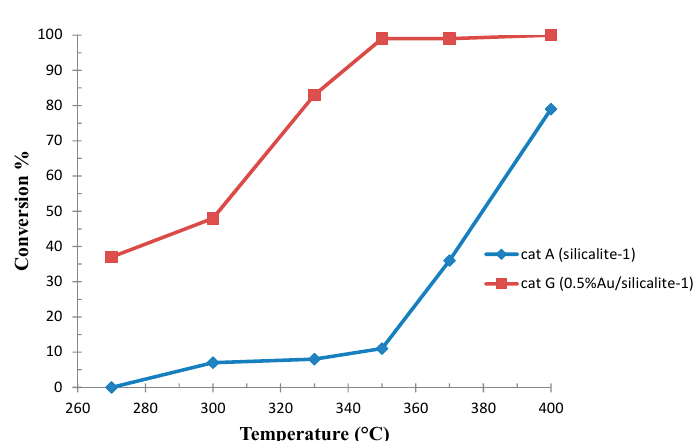
Figure 3. Comparison between unloaded silicalite-1 (cat A) and 0.5% Au/silicalite-1 (cat G) in ethanol conversion to Et 2 O and C 2 H 4 .